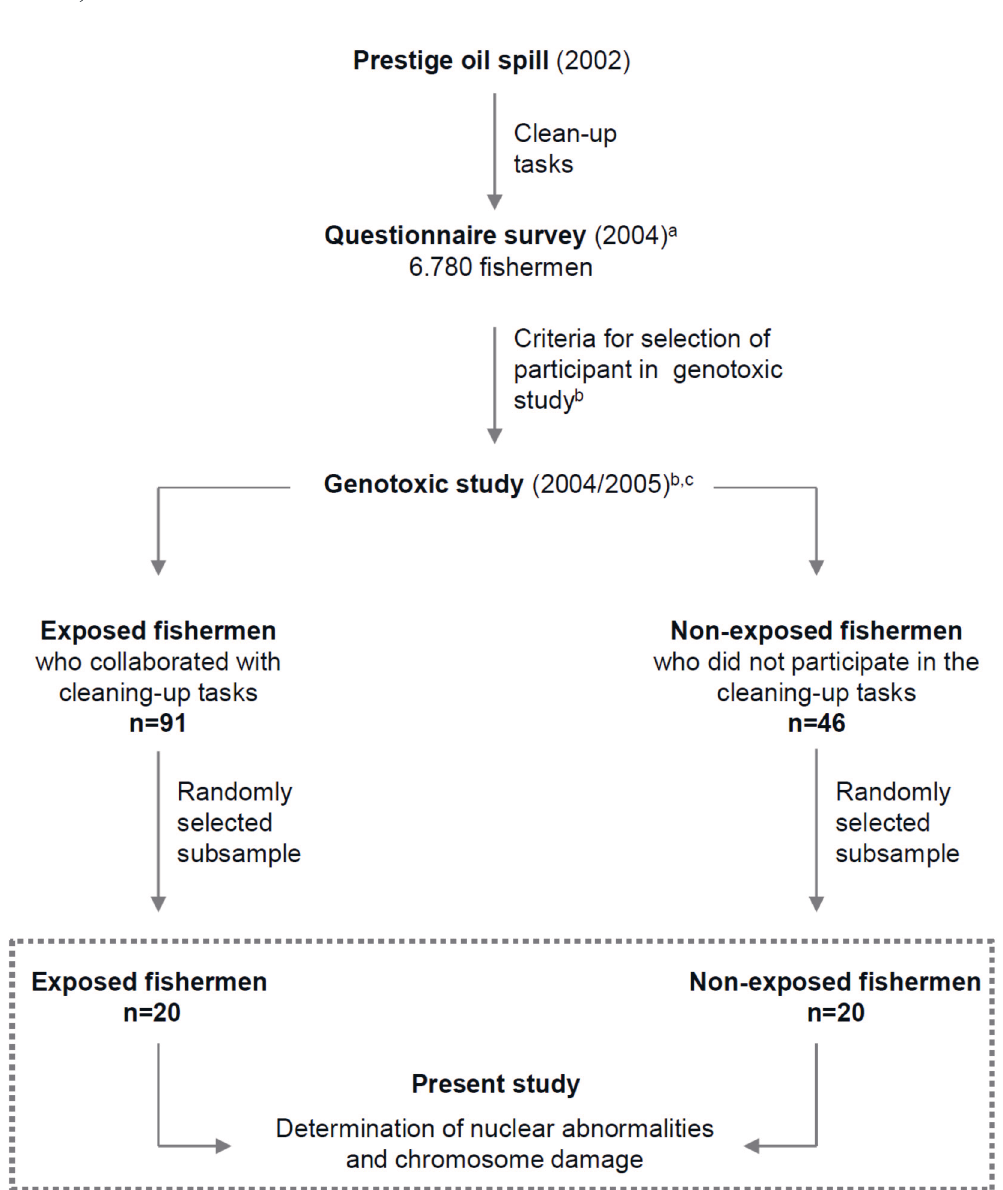
Figure 1. Flow diagram of the study. a Detailed description in Zock et al. [30]; b